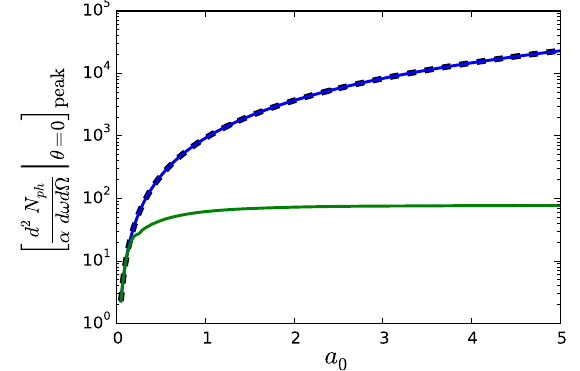
FIG. 4. Peakvalueoftheon-axisphotonspectrumasafunctionof a 0 forthecasesofunchirped(greensolidline)andproperlychirped (blue solid and black dashed lines) pulses. The black dashed line represents the fit to the numerical data given by Eq. (26).